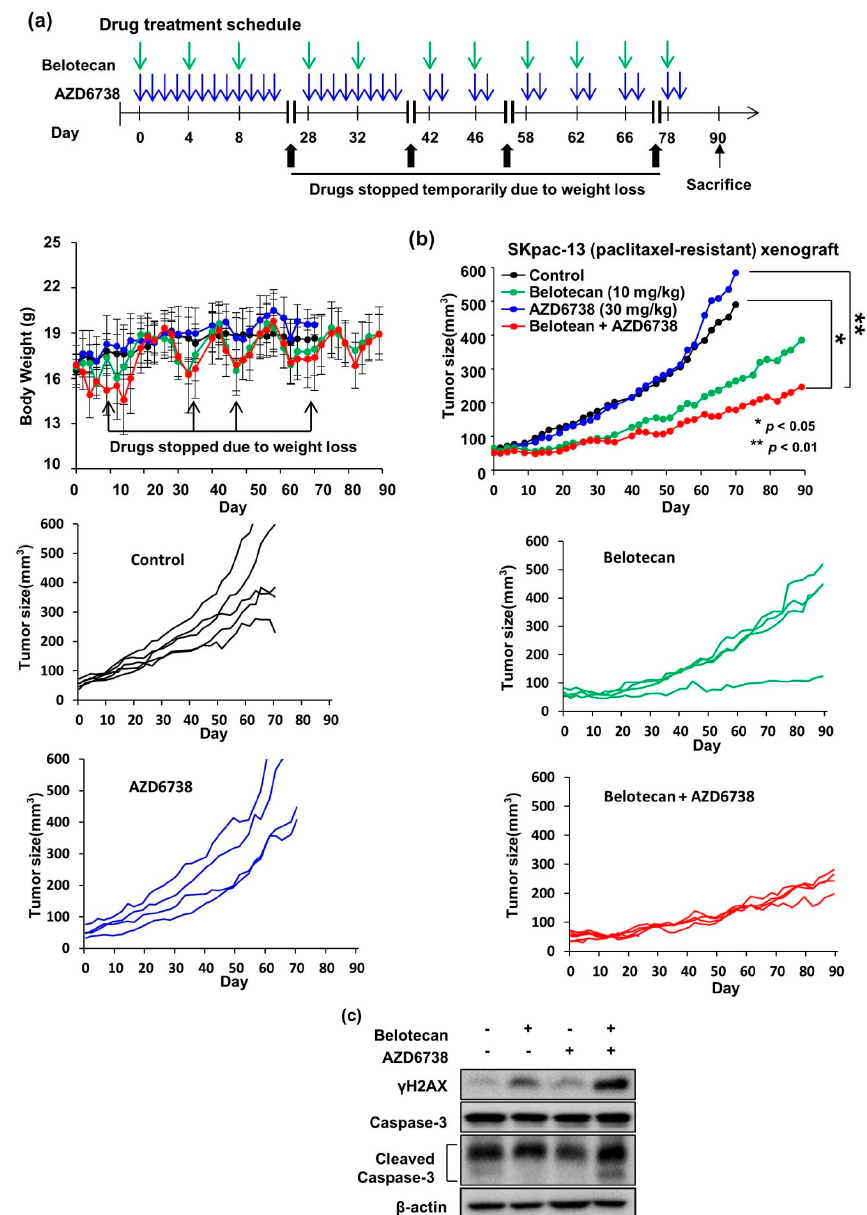
Figure 5. AZD6738 an ATR inhibitor in combination with belotecan demonstrate synergism in vivo using epithelial ovarian cancer cell line xenograft. ( a ) Drug treatment schedule and body weight change. AZD6738 30mg/kg was administered via oral gavage daily and belotecan 10 mg/kg was injected intraperitoneally every 4 days for single or combination dosages. In this combination dosage, mice lost weight by an average of 1.7 g on day 10 and appeared very sick. Then, both drugs were temporarily stopped until body weight was recovered. On day 28, both drugs were started again with the same schedule and dosages, but were stopped again with the re-occurrence of similar toxic effects on day 35. Starting on day 42, we started dosing again with a different dosing schedule of AZD6738 from daily dosing to 2 days on/2 days off. After intermittent dosing, the weight loss was reduced to an average of 1.1 g per mouse. ( b ) Combined AZD6738 30 mg/kg (oral gavage, daily but changed to 2 days on and 2 days off from day 42) and belotecan suppressed tumor growth more effectively than the no-treatment control or each single treatment. In the right panel, the average tumor sizes of all mice in each group are depicted. In the right and left panel, the tumor sizes of individual mice in each group are depicted. The tumor size of individual mice in a graph (combination group) depicted for 6 mice. At the beginning, 6 curves can be seen, but only four curves are visible at the end as two mice died in the early stage. p values were calculated using student t-test, where * p < 0.05, ** p < 0.01. Data are presented as mean ± standard deviation. ( c ) Western blot using SKpac-13xenograft after 90 days of treatment. Beta actin was used as a loading